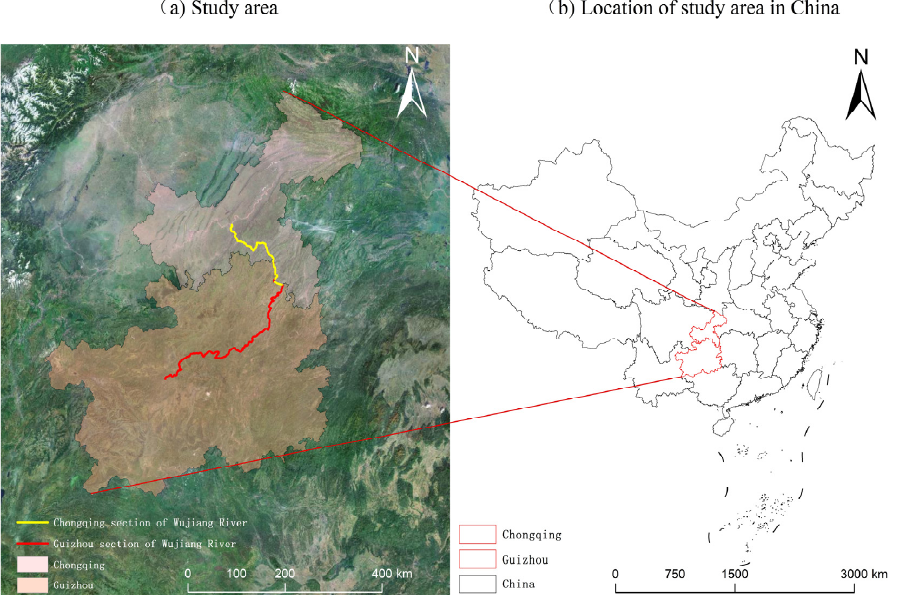
Figure 2. The location of study area.